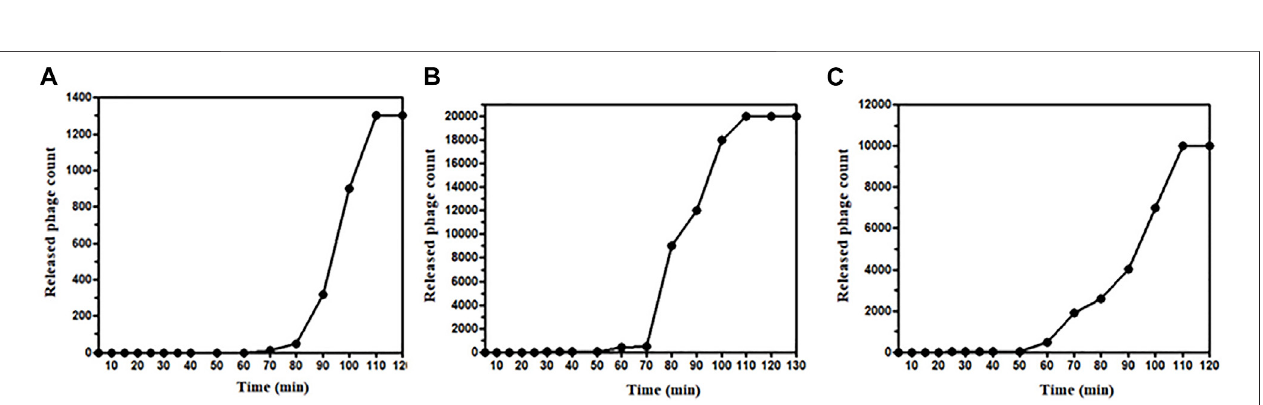
FIGURE 2 | One-step growth curve of bacteriophages; ɸ KpBHU4 (A) , ɸ KpBHU7 (B) , ɸ KpBHU14 (C) for estimation of burst size.